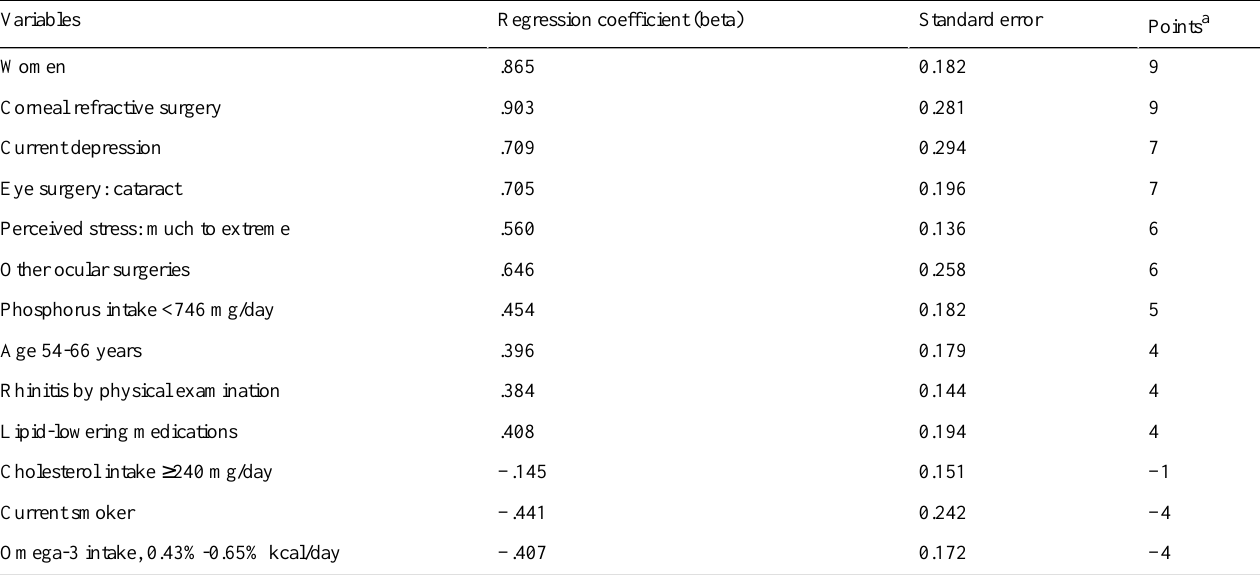
Table 1. Point-based scoring system for assessing individual risk of dry eye disease using coefficients from a survey-weighted multiple logistic regression model.